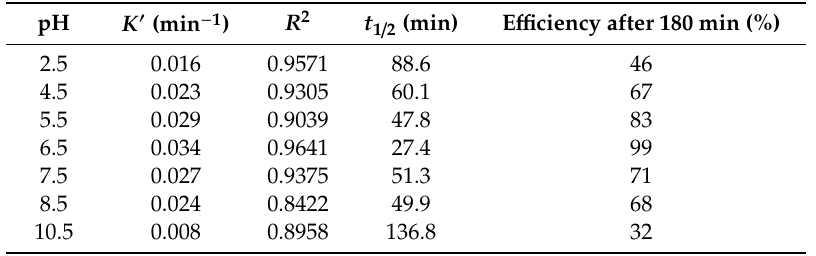
Table 1. Values of the photodegradation parameters calculated from Equations